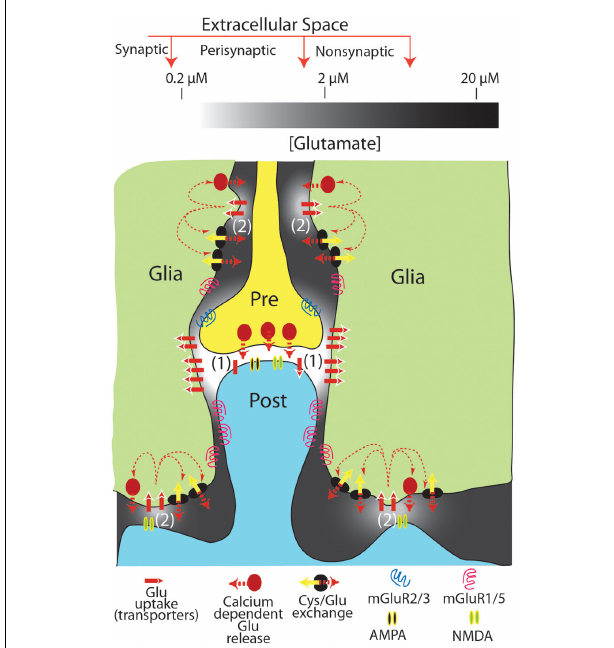
FIGURE 1 |Tonic levels of extracellular glutamate measured in the synaptic, perisynaptic, and nonsynaptic compartments of the extracellular space. The levels of glutamate shown are approximated for resting conditions (i.e., in the absence of action potential mediated synaptic release). It is proposed that extracellular glutamate in compartmentalized morphologically by close appositions between neuronal and glial processes (note that the distances between glia–neuron distances are exaggerated for illustrative purposes), and by the patterned distribution of glutamate uptake sites and neuronal or glial release sites.This creates 2 regions of nanomolar glutamate high in iGluR, uptake sites and either synaptic (1) or glial (2) glutamate release sites. A second region surrounding the nanomolar region contains low micromolar levels of glutamate that are maintained largely from glial release and relatively lower glutamate uptake via high affinity transporters.This latter compartment is in part populated by mGluR that receive tonic glutamate stimulation and thereby modulate synaptic (and probably glial; D’Ascenzo et al., 2007) release and